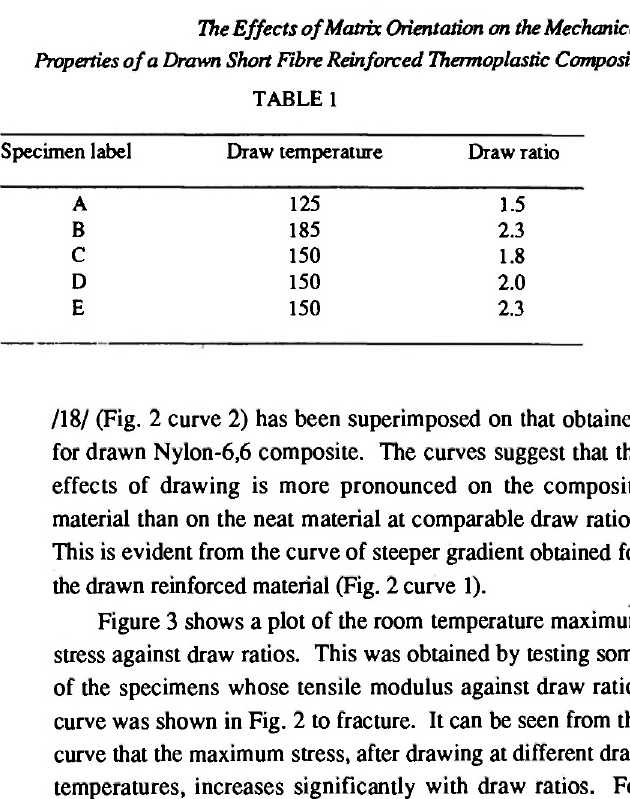
Fig. 1: Typical drawn specimens of injection moulded 5% CFR Nylon-6,6 composite drawn at different draw temperatures and draw ratios showing the extent of